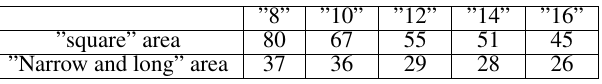
Table 5. Deployment numbers of two types of regional base stations under different Sharing-Value